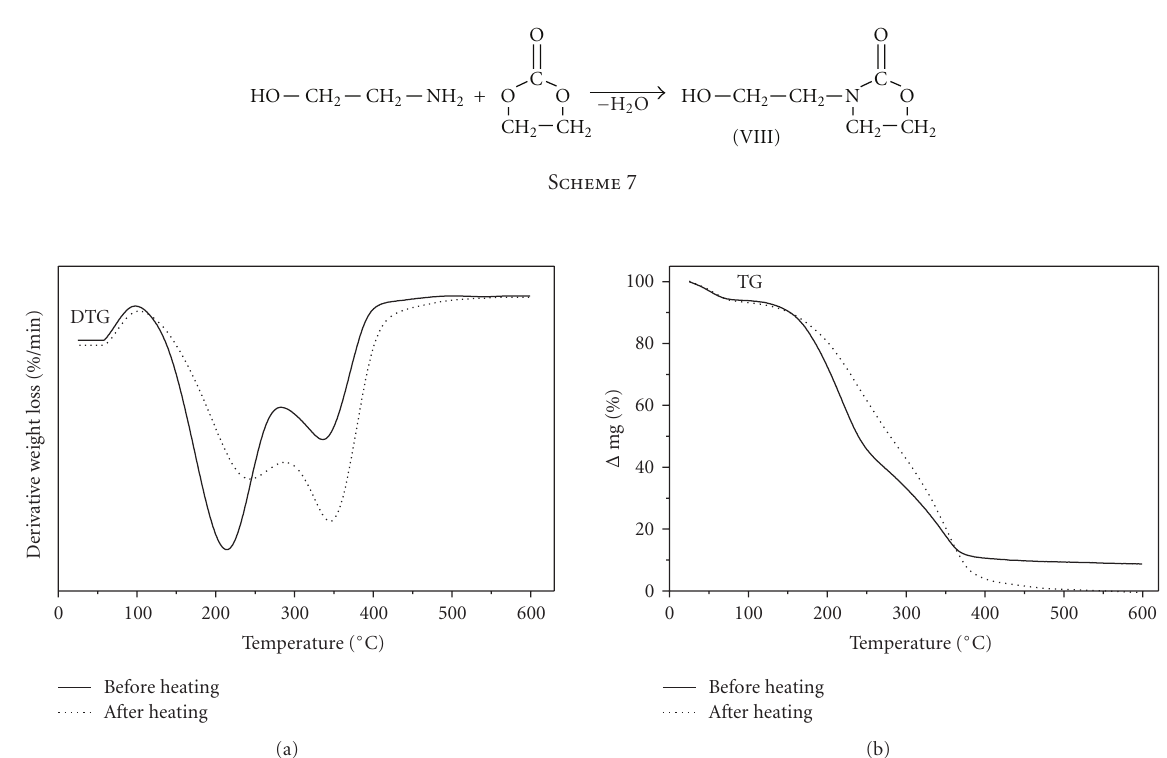
Figure 5: Thermal analysis of the reaction product of BHEOA:EC 1: 10 in the presence of 0.06 mole K 2 CO 3 /mole OA at 160 ◦ C: (a) before heating at 200 ◦ C, (b) after heating at 160 ◦ C for 4